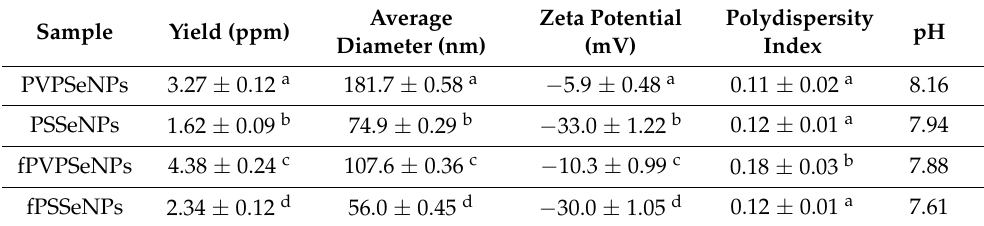
Table 1. Average yield, diameter, zeta potential and polydispersity index of SeNPs. Sample Yield (ppm)